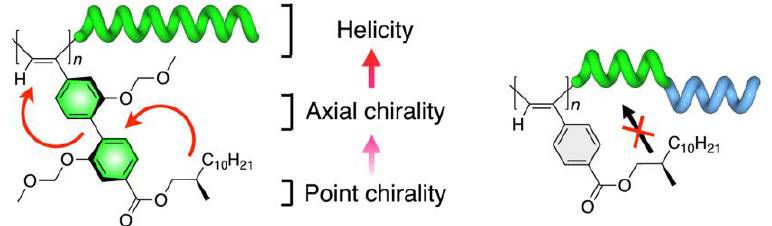
Figure 12. Illustration of the chiral induction form the peripherical chiral moiety to the polymer backbone [42].